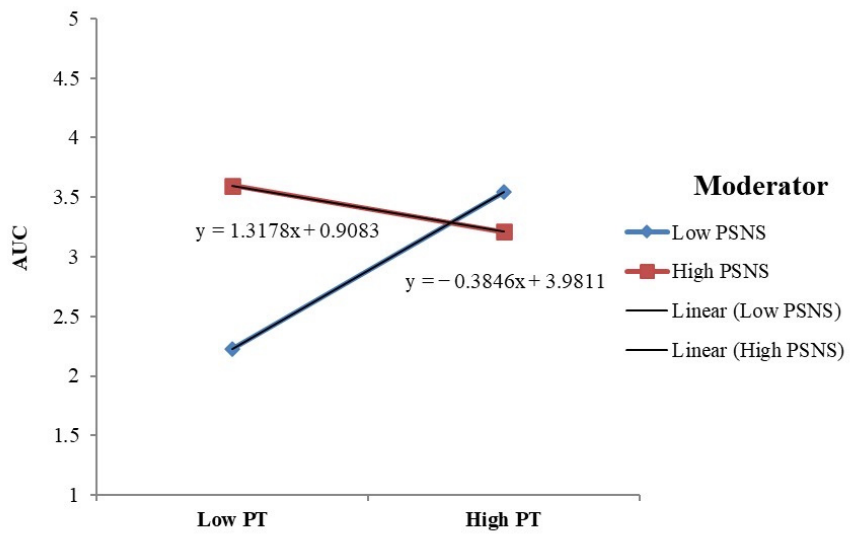
Figure 2. PSNS’s high and low effects on AUC through PT.